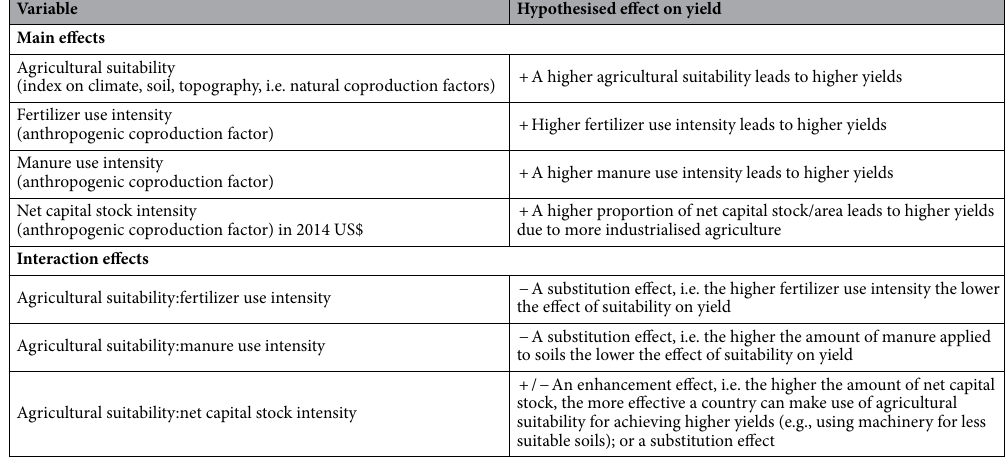
Table 2. Explanatory variables and